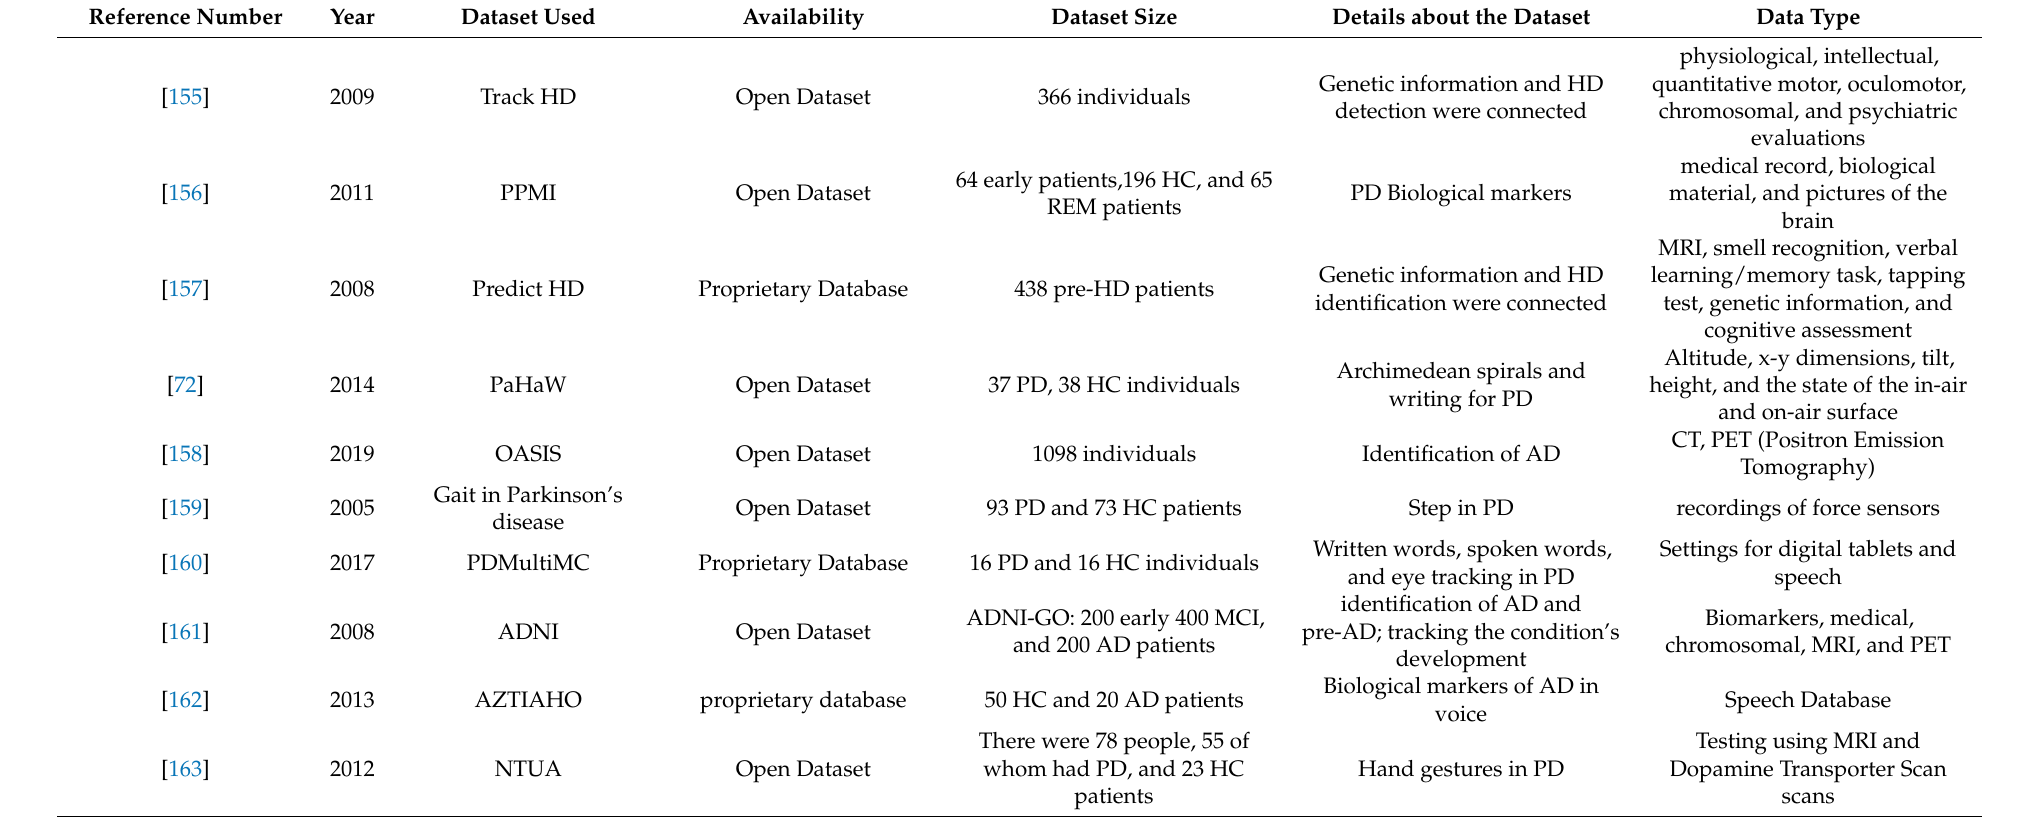
Table 4. List of Various Parkinson’s Disease Diagnosis